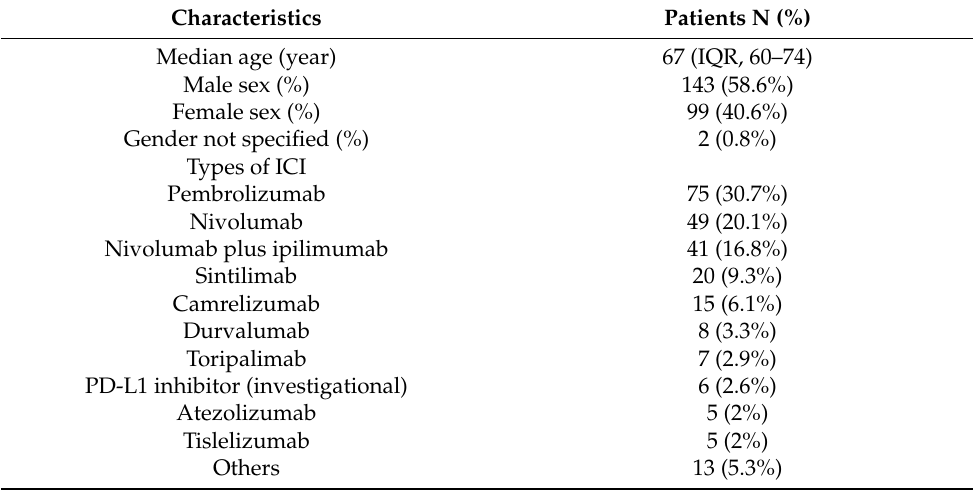
Table 3. Demographic and clinical characteristics of individual case reports.